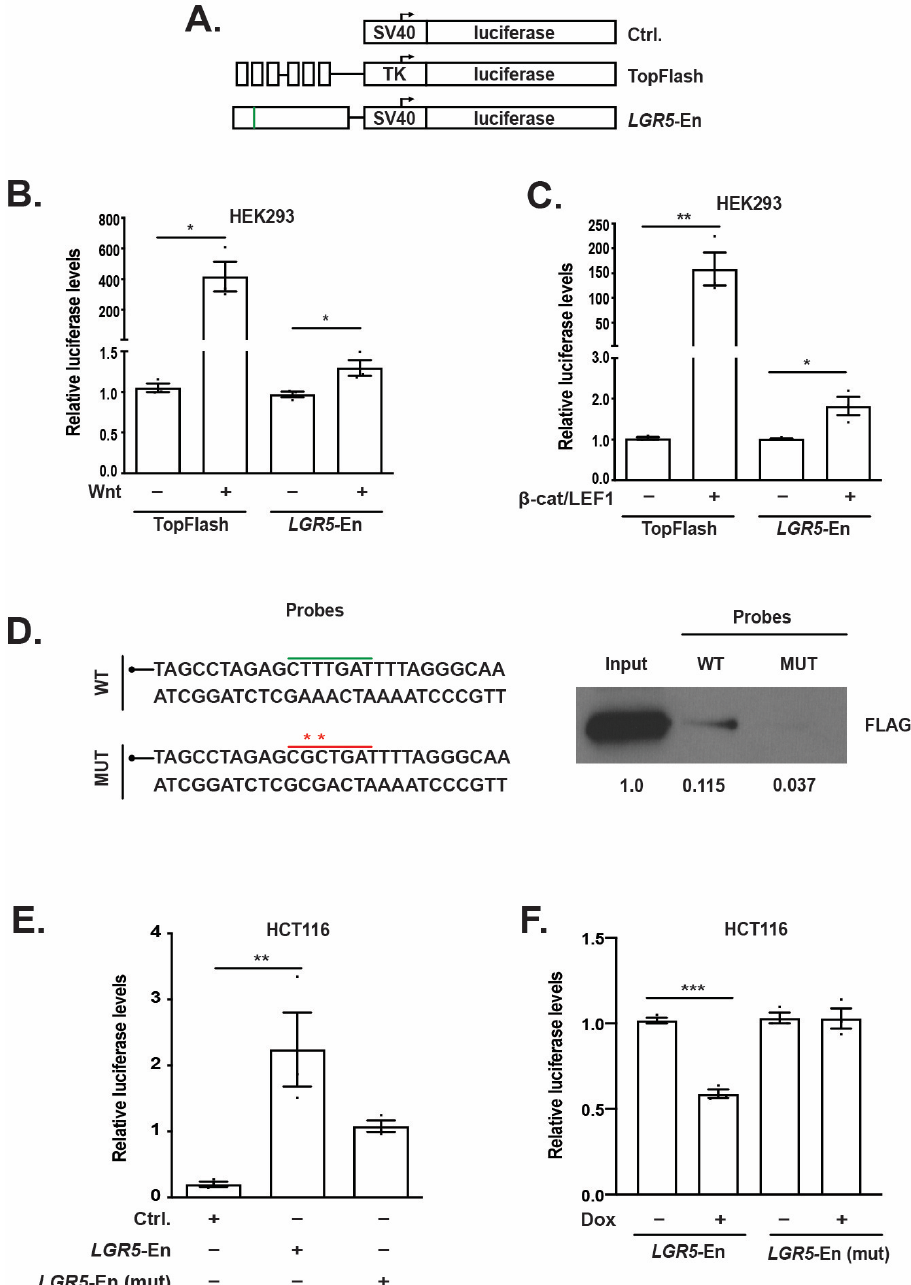
Figure 3. TCF7L1 occupancy demarcates a WRE at the LGR5 locus that requires a TBE for full activity. ( A ) Diagram of luciferase reporter plasmids. ( B ) Luciferase levels expressed in HEK293 cells transfected with a reporter plasmid harboring a region of the LGR5 proximal promoter ( LGR5- En) or TOPflash. Where indicated, cells were treated with Wnt3a-conditioned media. ( C ) As in ( B ), except HEK293 cells were or co-transfected with plasmids encoding β -catenin and LEF1 as indicated. (D ) DNA sequence of binding assay probes flanking the consensus TBE (underlined in green for wild-type sequence or red for mutant sequence) with the engineered mutations indicated by asterisks. Western blot analysis of FLAG-tagged TCF7L1 from FLAG-TCF7L1 HCT116 protein lysates that were incubated with the biotinylated DNA probes indicated. ( E ) Luciferase levels expressed in HCT116 cells transfected with control (Ctrl.), LGR5- En, or LGR5- En (mut). ( F ) Luciferase levels expressed in control (− Dox) or Dox-treated FLAG-TCF7L1 HCT116 cells transfected with LGR5- En or LGR5- En (mut), as indicated. Error bars represent SEM (* p < 0.05, ** p < 0.01 , *** p < 0.001).